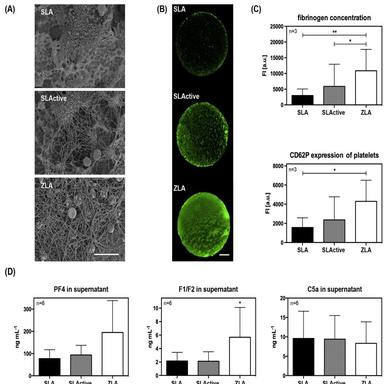
Blood coagulation on the implant surface samples after incubation in partially heparinized whole blood or PRP. Fibrin network formation on the different implant surfaces after whole blood incubation was evaluated by (A) SEM imaging (scale bar 20 m) and after incubation in PRP by (B) a microarray scanner (scale bar 1mm) after staining of fibrinogen (green). (C) Fibrin and platelet activation (CD62P) were quantified with a microarray scanner. (D) Selected molecular markers of the coagulation cascade, i.e. PF